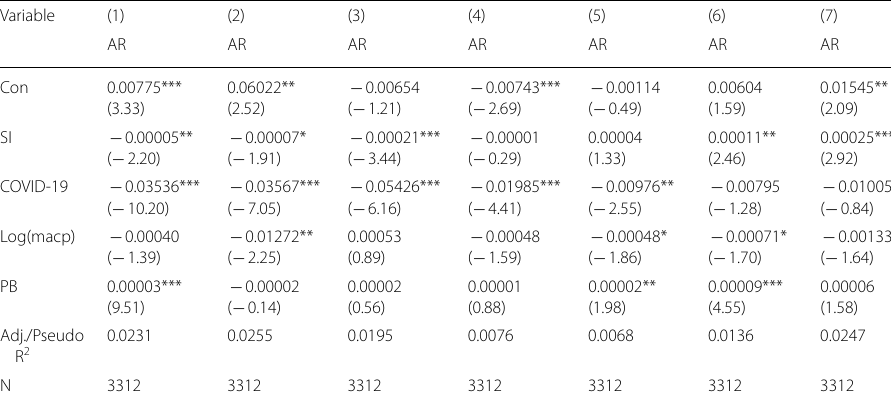
Table 5 The results of the robustness